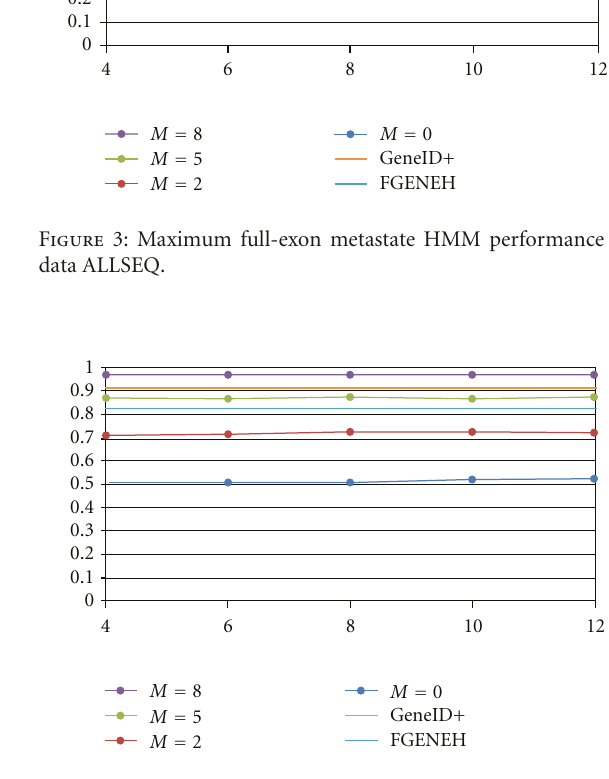
Figure 4: Maximum base level metastate HMM performance for data